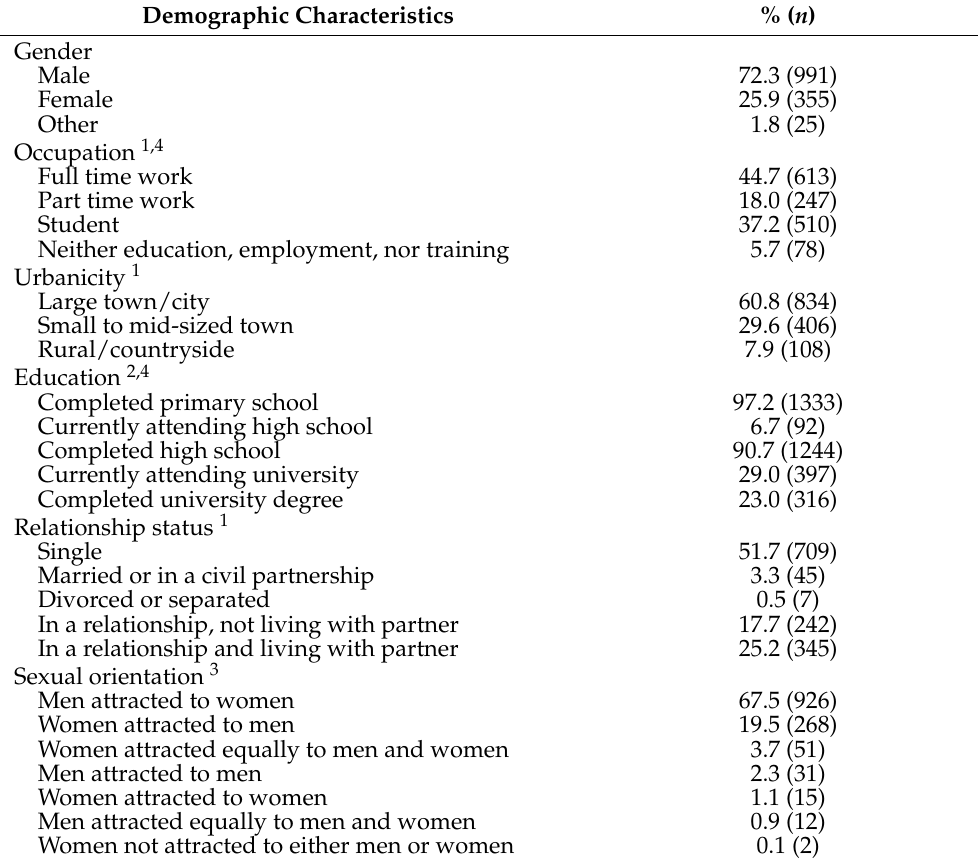
Table 1. Demographic characteristics of the participants ( n =